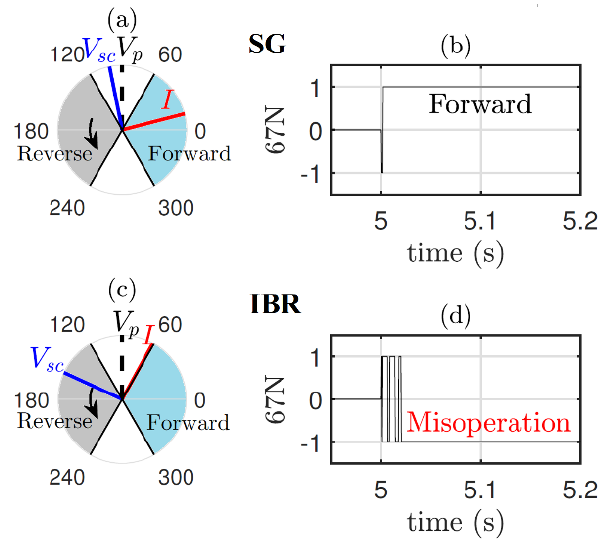
Figure 5. Phasor diagram and response of 67N element under the two scenarios of Section 3.2: ( a ) phasor diagram under SG; ( b ) response of 67N under SG; ( c ) phasor diagram under IBR; and ( d ) response of 67N under IBR.